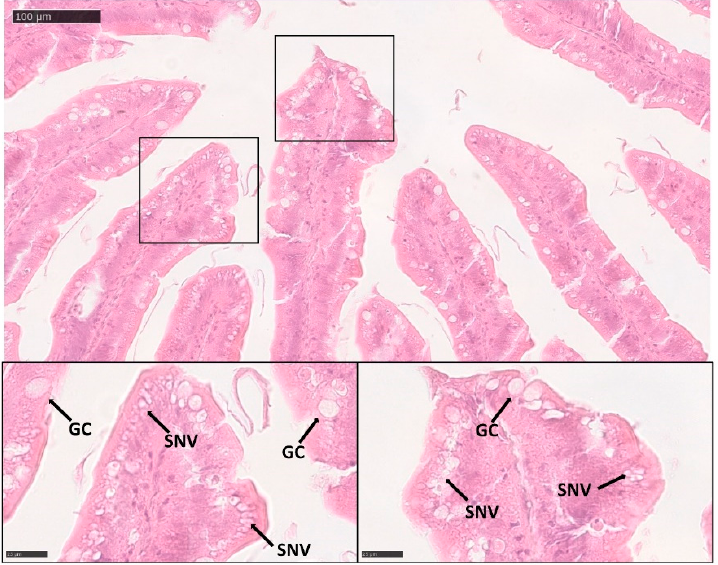
Figure 2. Hematoxylin/eosin (HE) stained section, showing the presence of enterocytes supranuclear vacuolization (SNV) and goblet cells (GC) in the pyloric caeca of 500 gr rainbow trout.